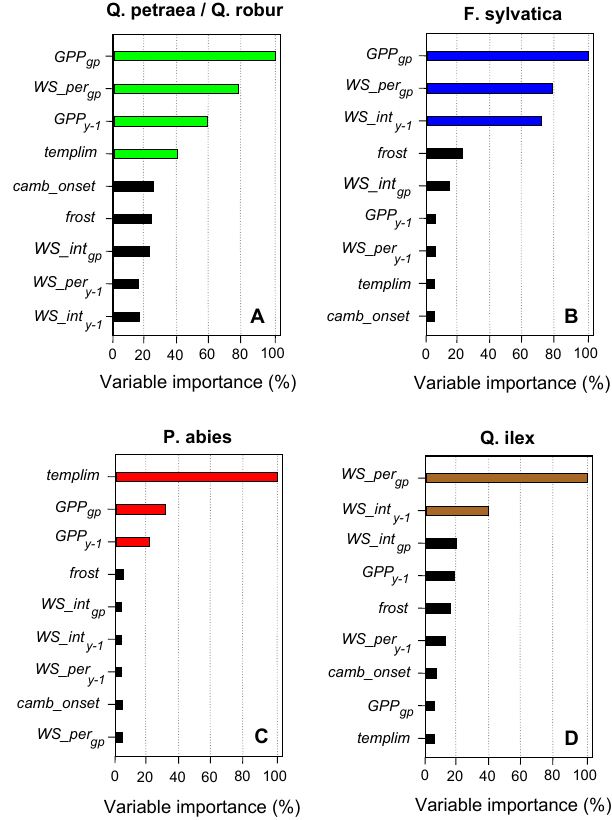
Figure 4. Temporal dependences of annual wood growth: the roles of explanatory variables from RF classification. Variable impor- tance is expressed as the percentage of the importance of the top- ranked explanatory variable. The variable identifiers (IDs) are listed in Table 2. The coloured variables were retained in subsequent anal-